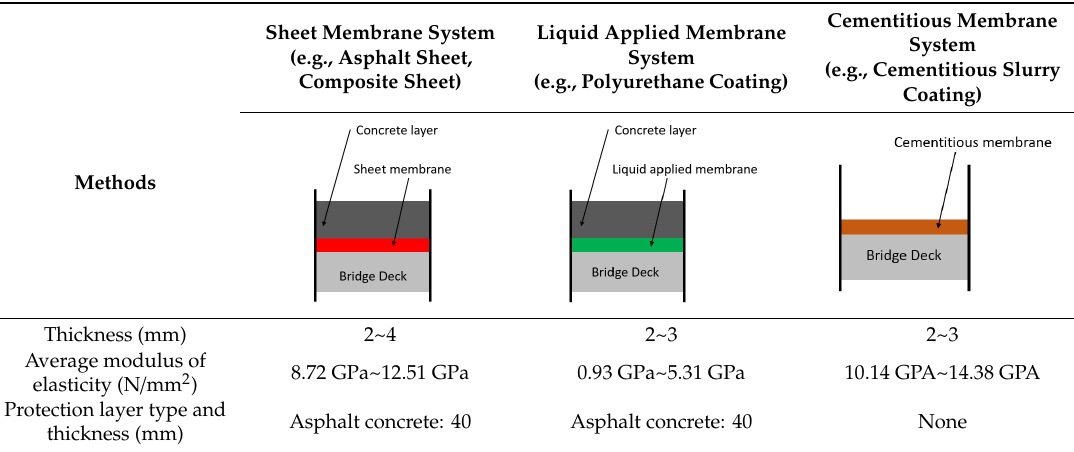
Table 1. Representative waterproofing systems of railroad bridges decks.